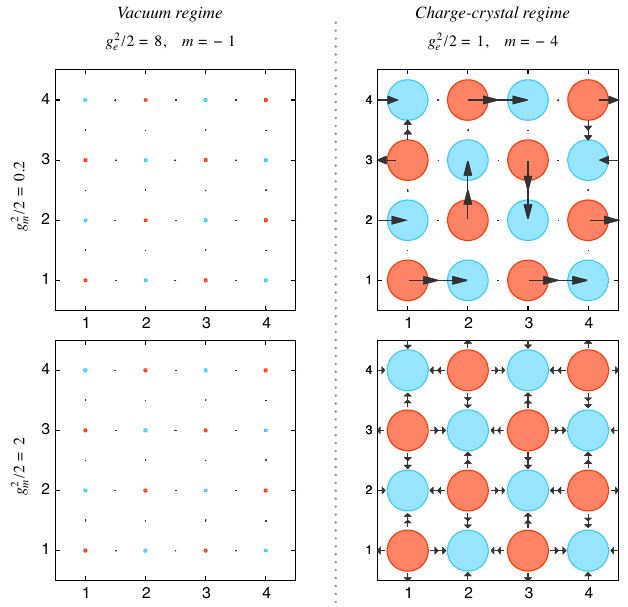
FIG. 5. Numerical results obtained via TTN simulations. The field plots reproduce the matter and gauge configurations for a 4 × 4 subsystem embedded in an 8 × 8 lattice with periodic boundary conditions. Red (blue) circles represent particles (antiparticles): Their diameter indicates the average density, from 0 (empty sites) to 1 (completely filled). The arrows in between represent the electric field: Larger arrows indicate greater electric flux.